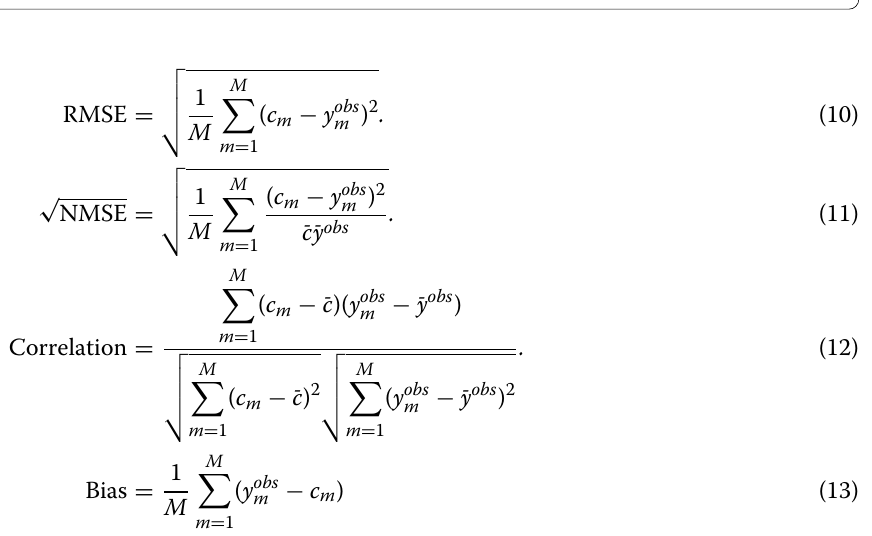
Fig. 7 Simulation of NO 2 concentrations µ gm − 3 by the full model Sirane and the meta-model chain for parameters corresponding to conditions on Tuesday November 18, 2014 at 8 a.m. The measurement locations used for comparison in “Comparison with observational data” section are shown over the meta-model solution by blue